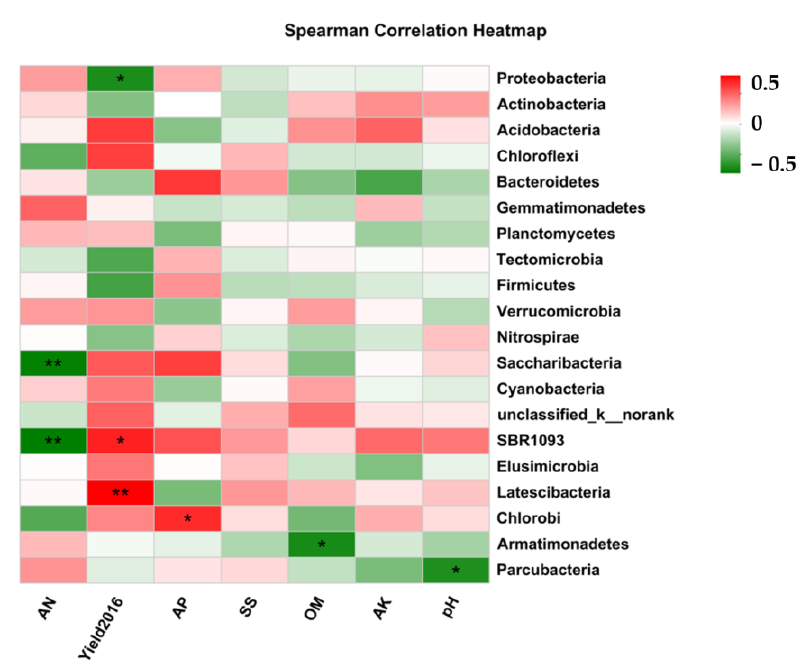
Figure 4. Correlation analyses among soil variables, NPP, and bacterial community structure. OM, organic matter; AN, available nitrogen; AP, available phosphorus; AK, available potassium; SS, soil salinity. Yield2016, the above net primary productivity in year2016. *, significant ( p < 0.05); **, significant ( p < 0.01); ns, not significant.